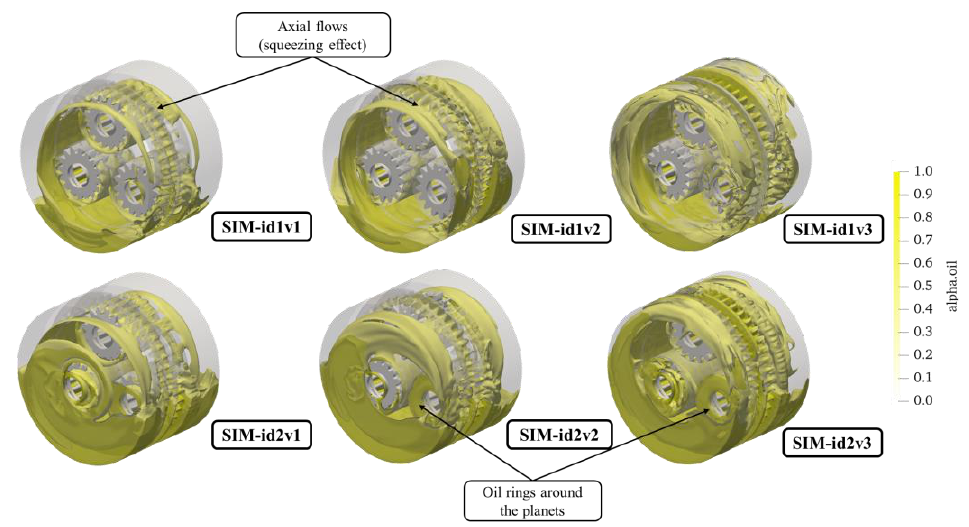
Figure 12. Oil distribution inside the gearbox for the analyzed operating conditions. Top row: low filling level cases. Bottom row: high filling level cases. Axial flows (squeezing effect) and oil rings around the planets are